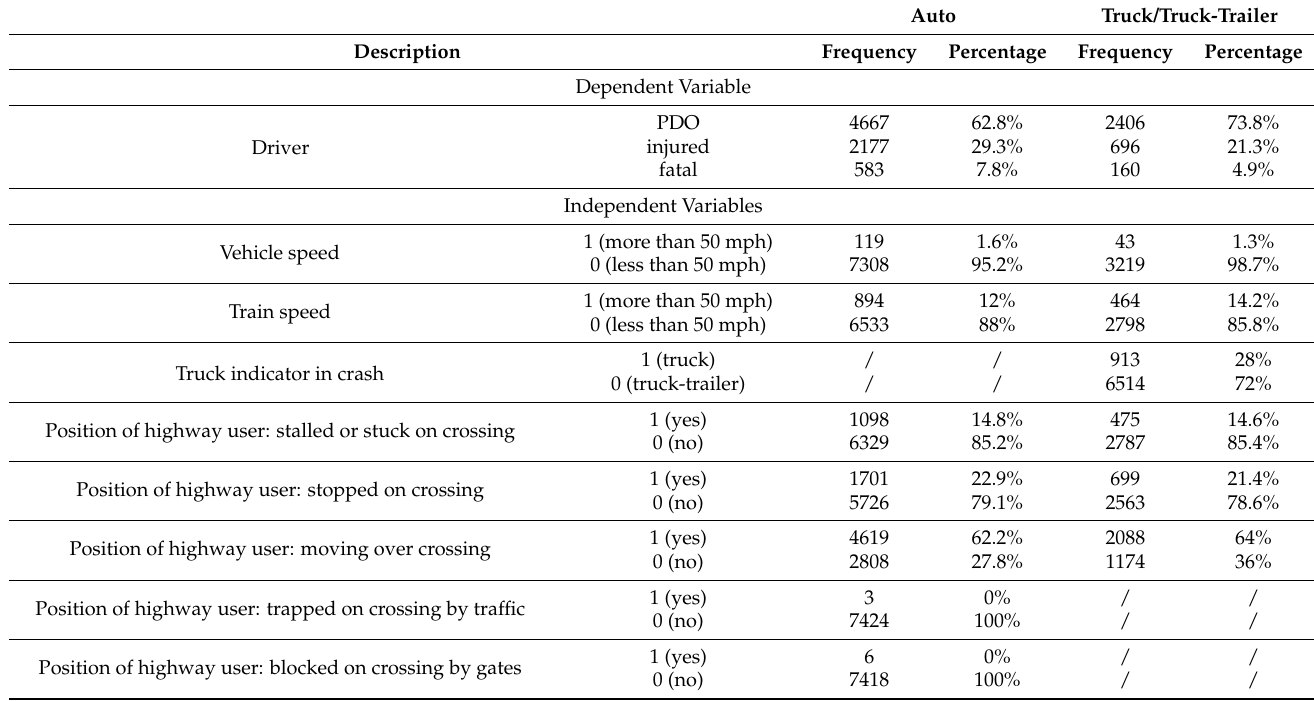
Table 2. HRGCs accident